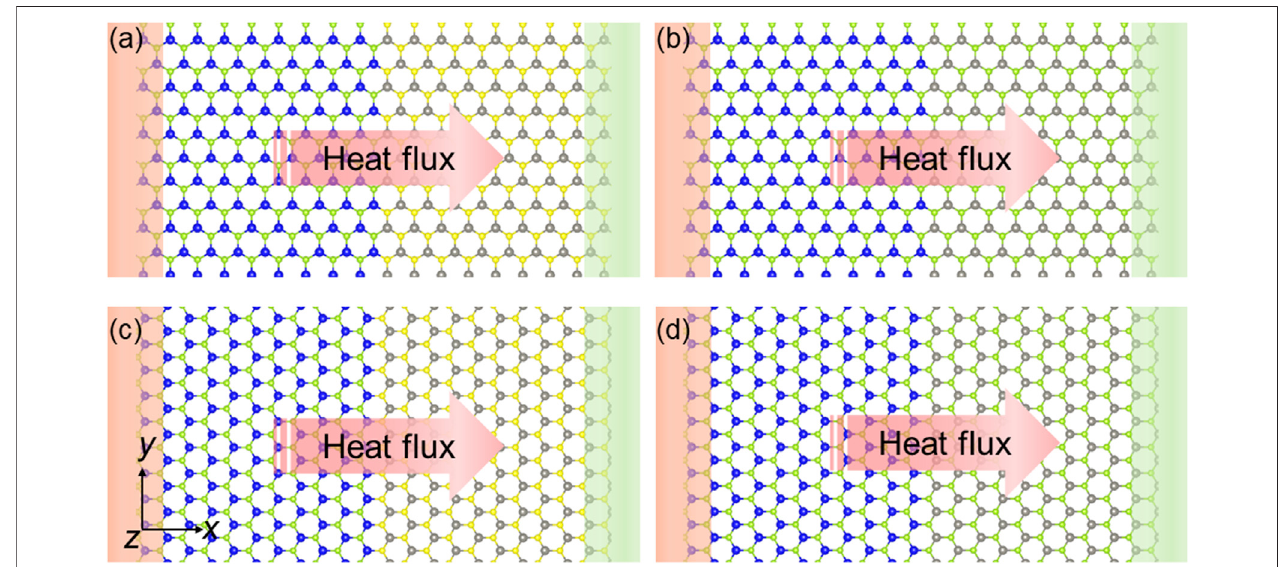
FIGURE 5 | Schematic of the heat transfer style of the (A) arm-1, (B) arm-2, (C) zig-1, and (D) zig-2 MoSSe/WSSe heterostructures for the NEMD simulations.